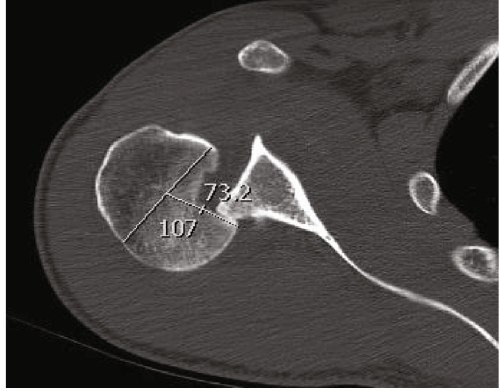
Figure 2: Reverse Hill-Sachs lesion of more than 40%.